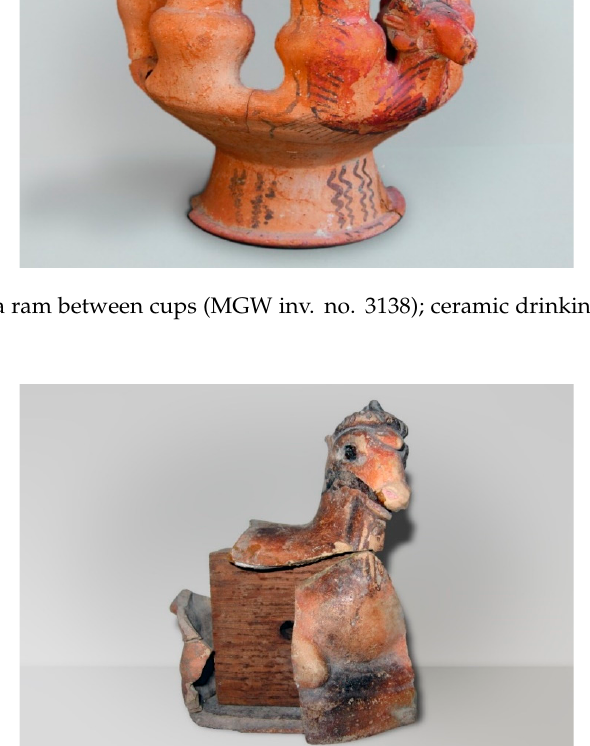
Figure 16. Rampant goats in a mosaic panel; drawing of a scene from the House of the Mosaics; ca. 6th–5th century BCE .